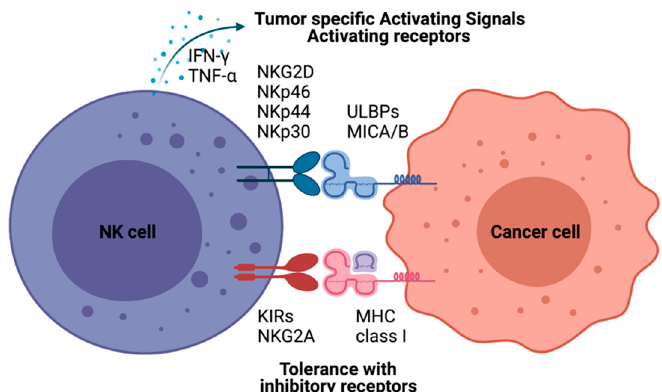
Figure 1. Natural killer (NK)-cell-mediated cytotoxicity. NK cell recognizes cells with NK cell receptors. MHC class I on target cells plays an inhibitory role binding to KIRs and NKG2A molecules resulting tolerance of NK cells as “self-recognition”. Otherwise, malignant cells inducing MICA/B, UL16 binding proteins (ULBPs), are detected by NK cells with NK-cell-activating receptors, including KG2D and NKRs. NK cells also have immune modulatory functions by producing IFN- γ and TNF- α to recruit other immune cells, such as dendritic cells and T cells.